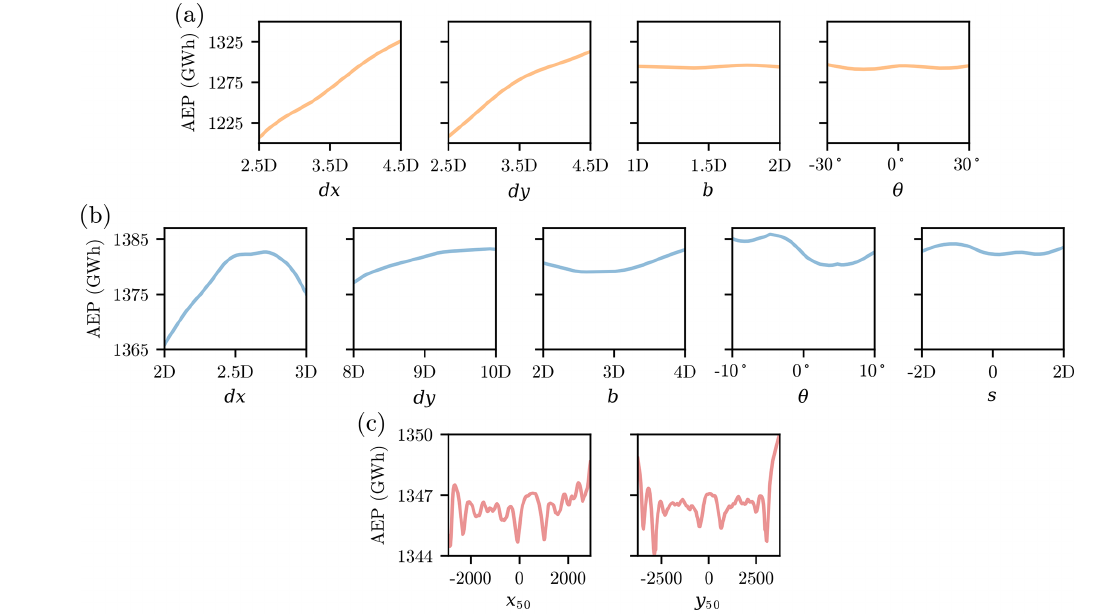
Figure 13. One-dimensional sweeps across the design space of each parameterization method discussed in this paper. These figures show the multimodality of each of the design spaces. (a) The simple grid parameterization. (b) Our newly presented boundary-grid parameterization. (c) Moving the location of one wind turbine across the wind farm in x and y (refer to Fig. 1). With the direct turbine layout definition there are actually 200 variables. This figure shows the multimodality in just two of these variables, where the whole design space is much more